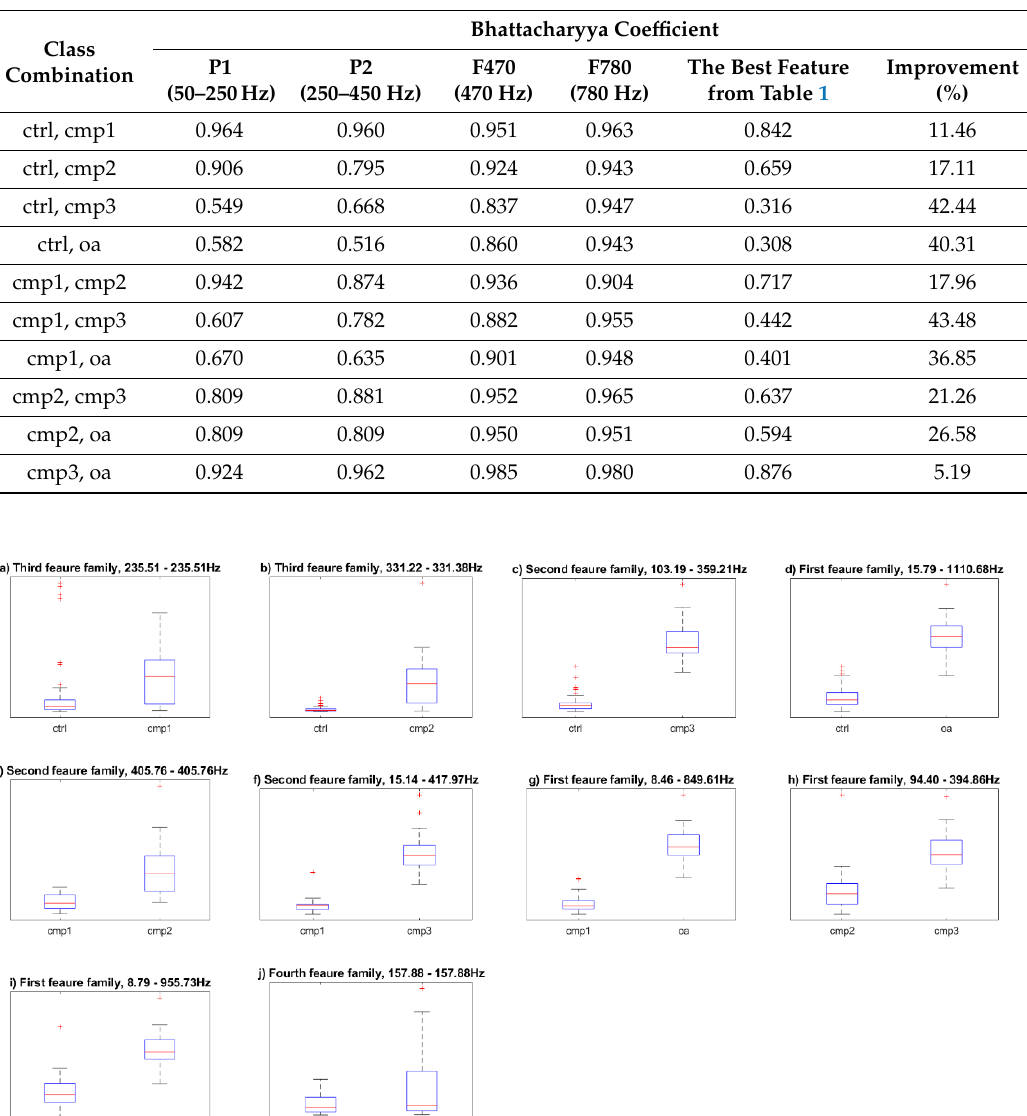
( B ) − B coefOLD coefNEW B coefOLD